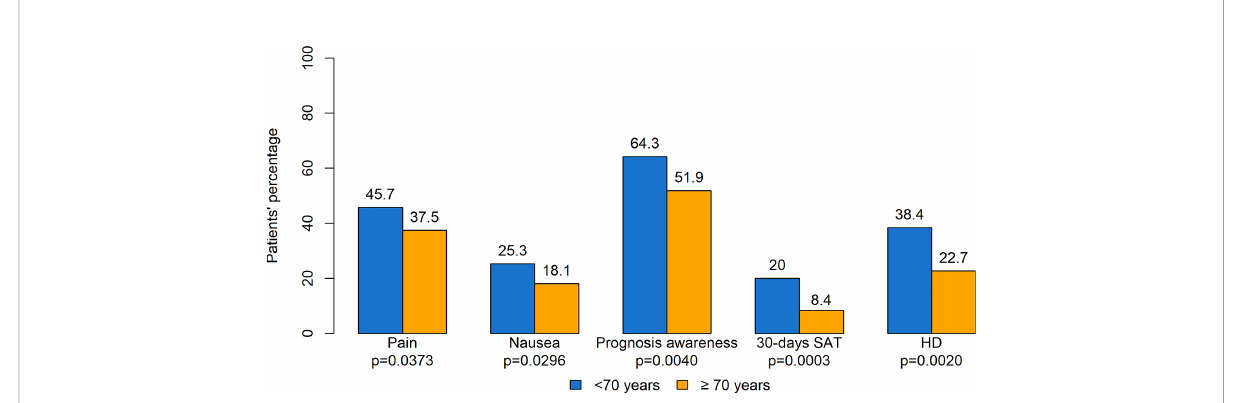
FIGURE 5 Statistically signi fi cant difference according to age. SAT, systemic anticancer therapy; HD, hospital